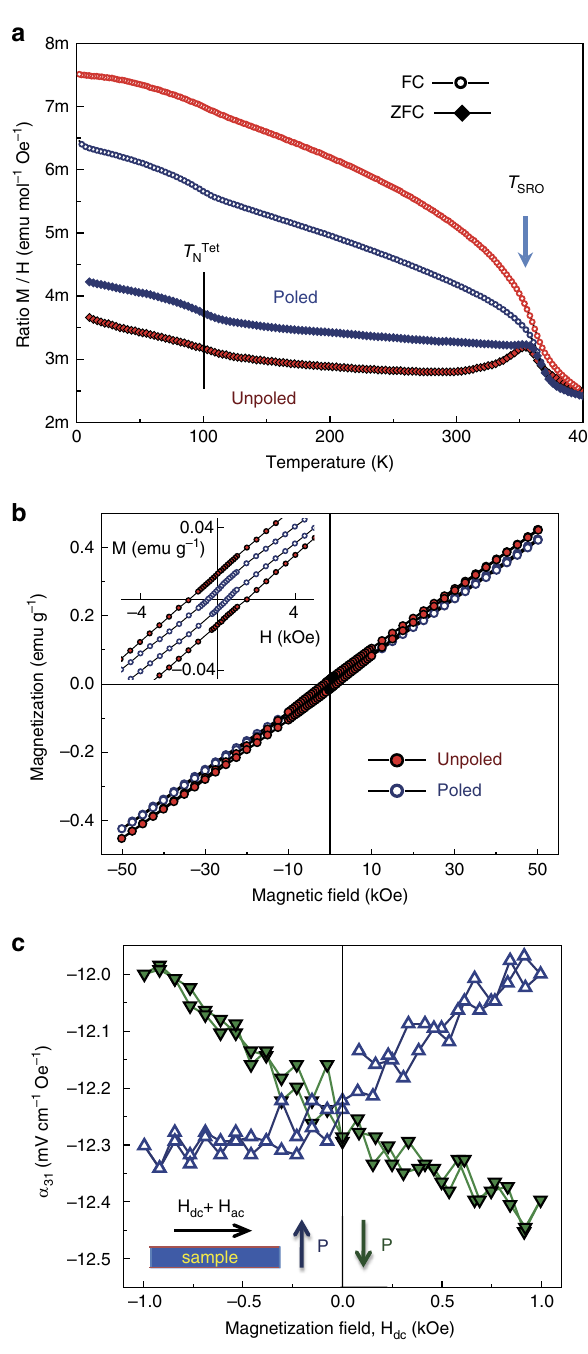
Figure 4 | Magnetoelectric coupling. ( a ) Zero-field-cooled (ZFC)/Field- cooled (FC) magnetization curves at 500Oe and ( b ) isothermal magnetization loops at 300K, for the unpoled and poled Bi 0.68 Pb 0.32 Fe 0.655 Mn 0.025 Ti 0.32 O 3 ceramic. Ne´el temperature ( T N Tet ) of the P 4 mm phase and magnetic anomaly associated with the spin-reorientation phenomenon ( T SRO ) within the Cc phase are indicated. A distinctive magnetoelectric response is anticipated, associated with the observed electric field-induced phase change between Cc and P 4 mm phases. ( c ) Linear magnetoelectric response was also found, as indicated by the magnetoelectric voltage coefficient ( a 31 ) as a function of a static magnetization field, H dc (open and closed symbols are for polarization pointing in antiparallel directions. The measuring configuration is illustrated in the